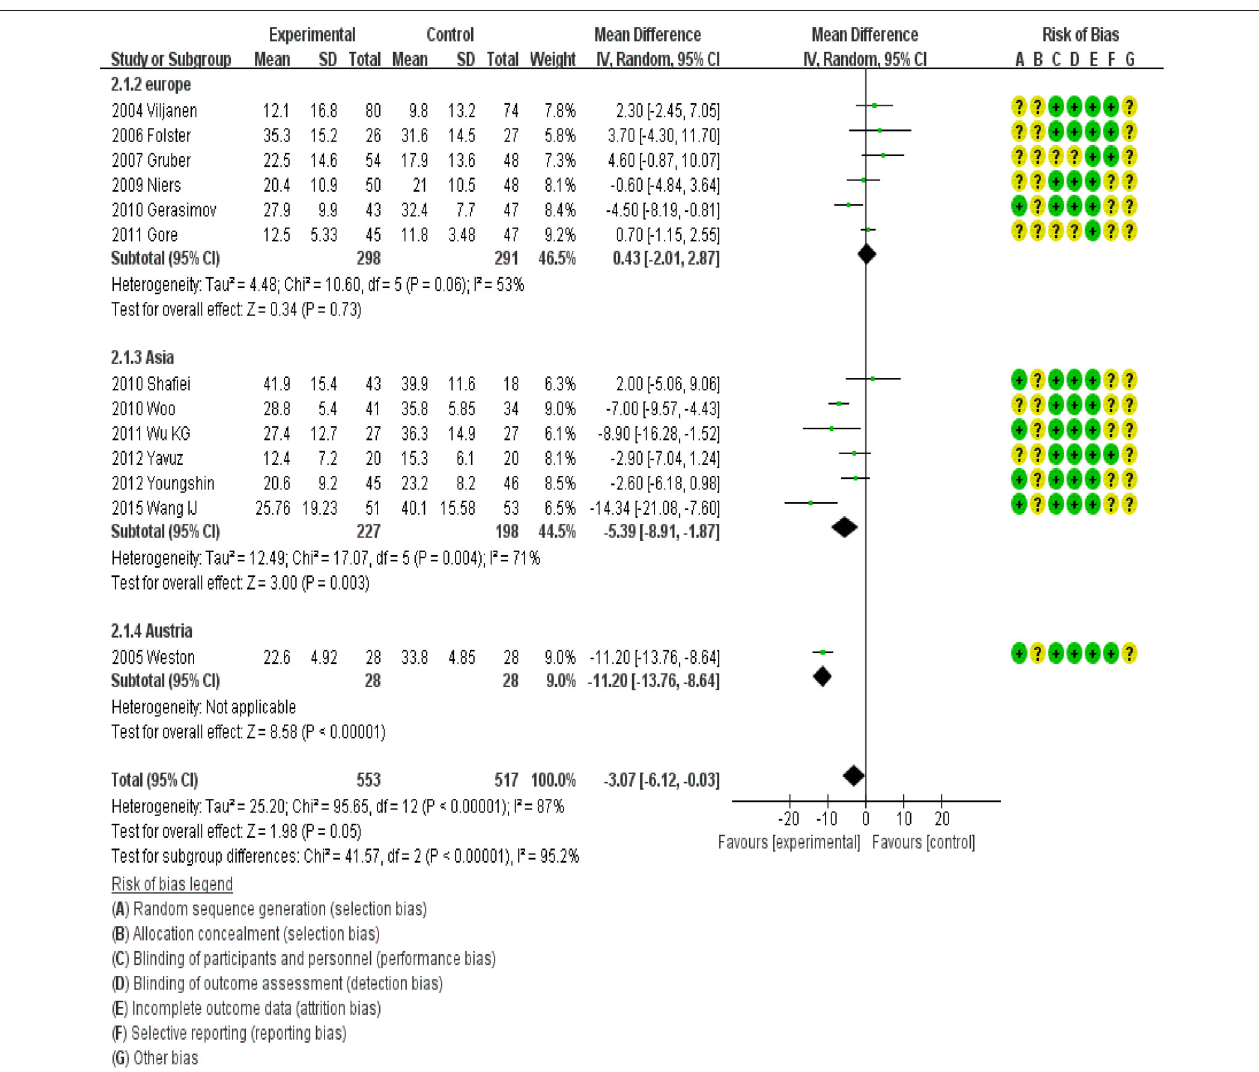
FIGURE 5 | MD scoring with probiotics treatment compared to control and placebo interventions by